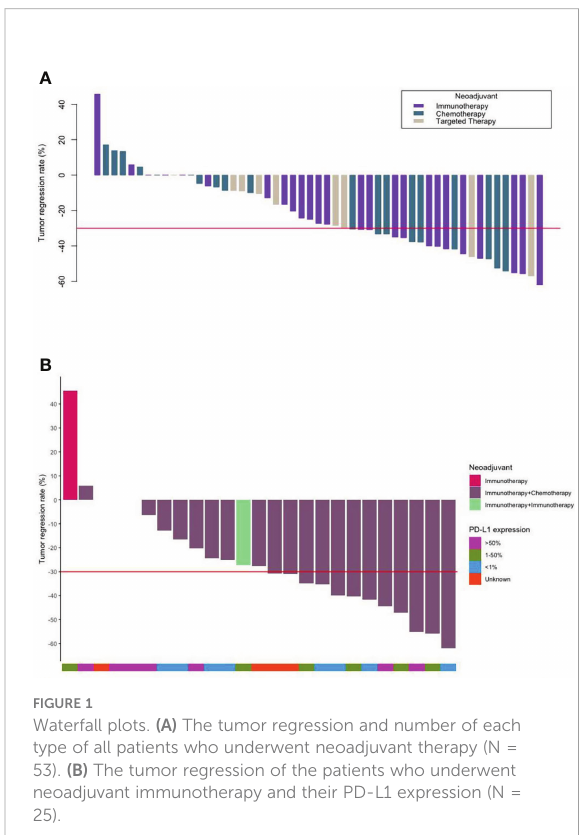
FIGURE 1 Waterfall plots. (A) The tumor regression and number of each type of all patients who underwent neoadjuvant therapy (N = 53). (B) The tumor regression of the patients who underwent neoadjuvant immunotherapy and their PD-L1 expression (N =